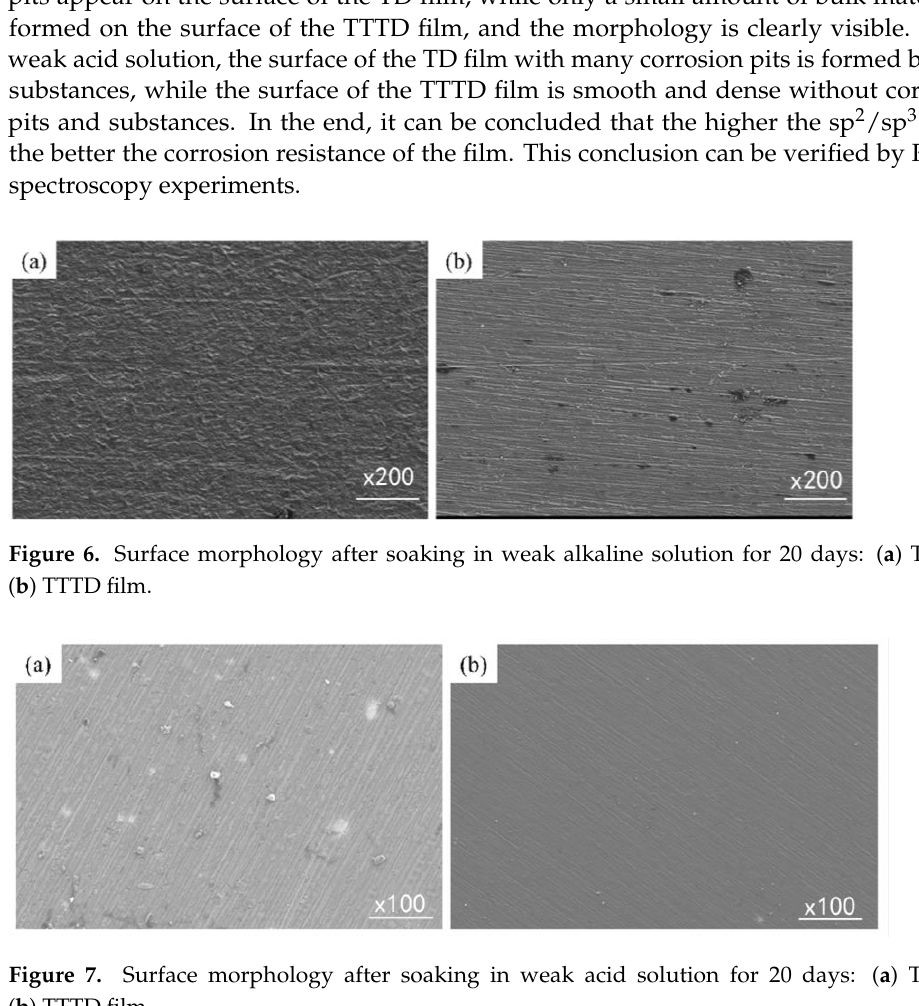
Figure 7. Surface morphology after soaking in weak acid solution for 20 days: ( a ) TD film ( b ) TTTD film.